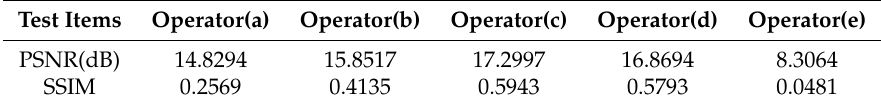
Table 1. PSNR and SSIM for different